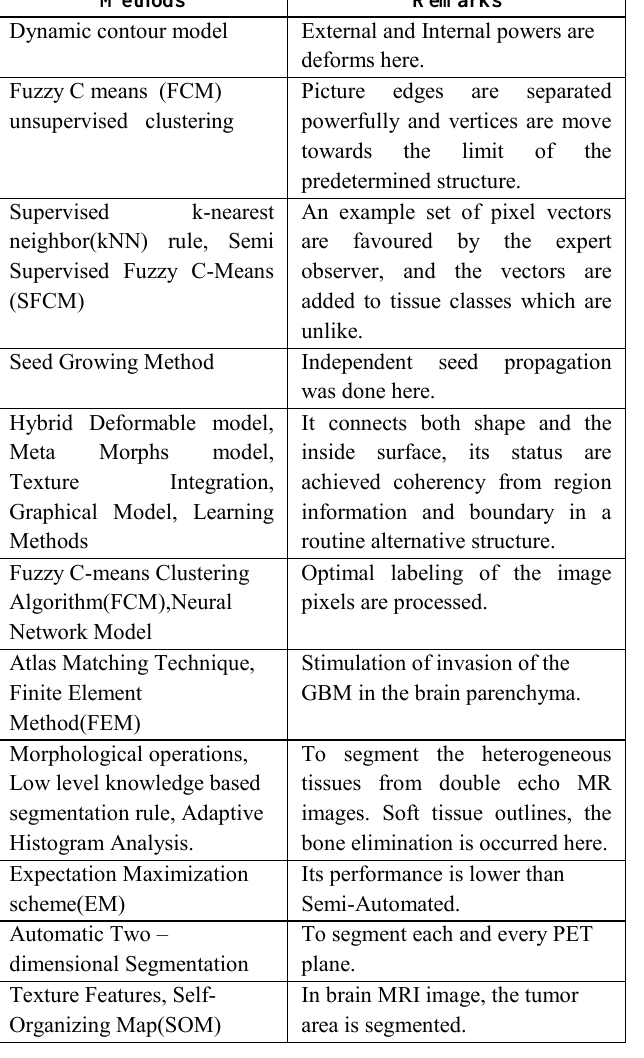
Table 1.3 An overview of Segmentation Algorithm